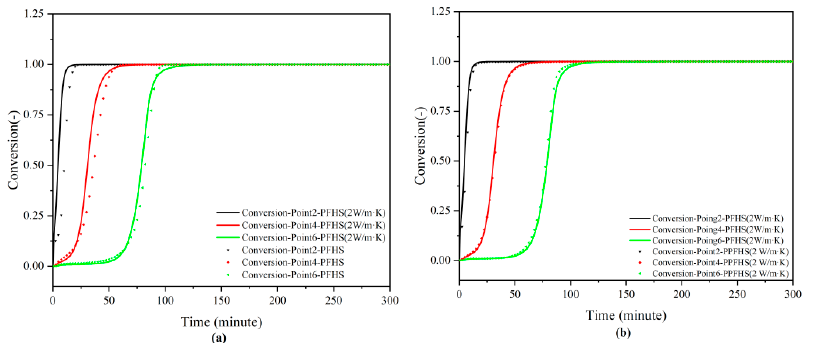
Figure 12. The conversion rate at the probe point far from the wall over time (hydration, ε = 0.5, 25 m/s). ( a ) PFHS (2 W/m · K) reactor compared with PFHS reactor. ( b ) PPFHS (2 W/m · K) reactor compared with PFHS (2 W/m · K) reactor.